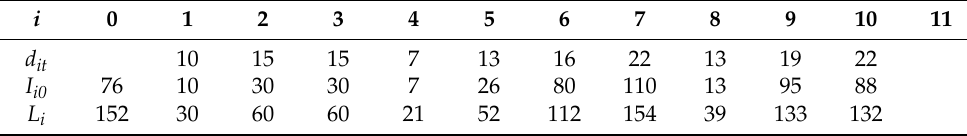
Table 3. Dataset ( n = 10, l = 6, k =